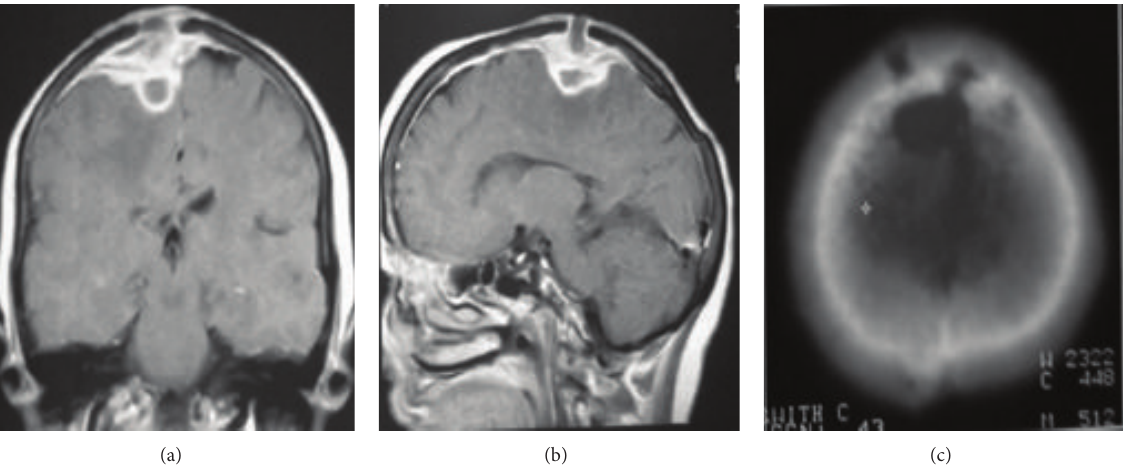
Figure 8: Tuberculous abscess with epidural and subdural empyema and calvarial osteomyelitis. Coronal (a) and sagittal (b) postcontrast T1-weighted MR images demonstrate epidural and subdural collections over the bifrontal cerebral convexities (more on the right side) with intraparenchymal and calvarial extension. Peripheral edema and irregular marked enhancement of the lesion as well as dural enhancement are evident. The bony destructive lytic lesions are seen in the bone window CT image (c).